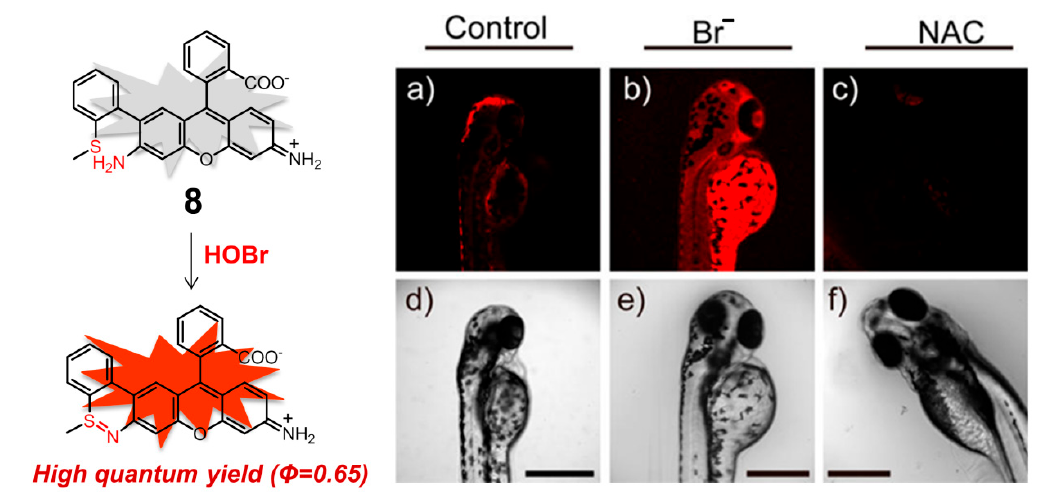
Figure 9. Mitochondria-targeting NIR fluorescent probe 8 for HOBr (left) and its fluorescence imaging of native HOBr in zebrafish (right). ( a ) Zebrafish fed with 8 for 30 min (50.0 μ M); ( b ) zebrafish fed with Br - (100 μ M) for 30 min followed by 8 (50.0 μ M) for another 30 min; ( c ) zebrafish incubated with NAC (a scavenger of HOBr,20.0 μ M) for 30 min followed by 8 (50.0 μ M) for another 30 min. ( d – f ) Correspond to bright-field images of ( a – c ). ( λ ex = 633 nm, λ em = 650–750 nm). Reproduced with permission from Reference [91]. Copyright 2017 American Chemical Society.